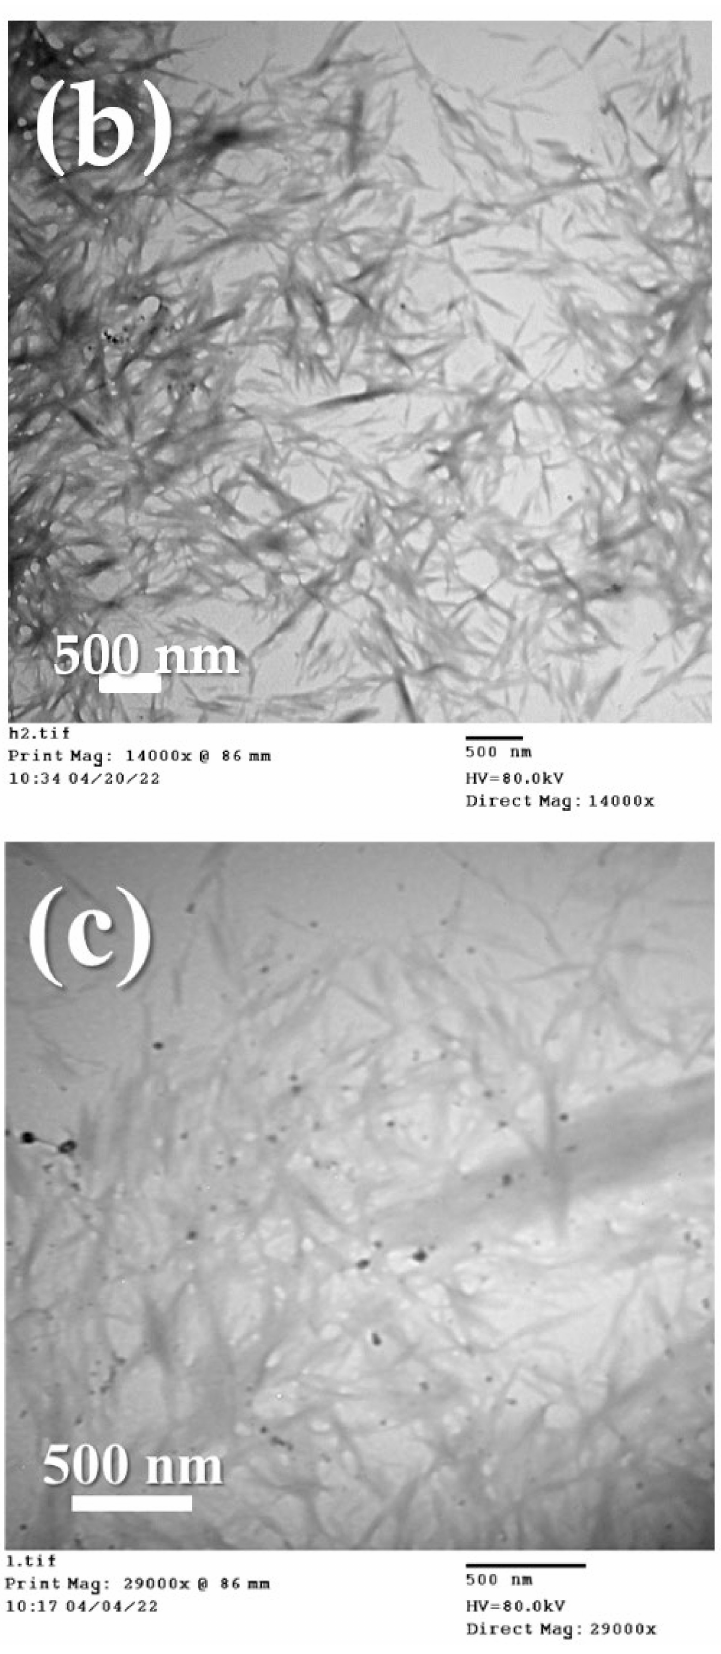
Figure 2. TEM images of ( a ) Fe 3 O 4 NPs, ( b ) nanocellulose, and ( c ) Fe 3 O 4 /cellulose